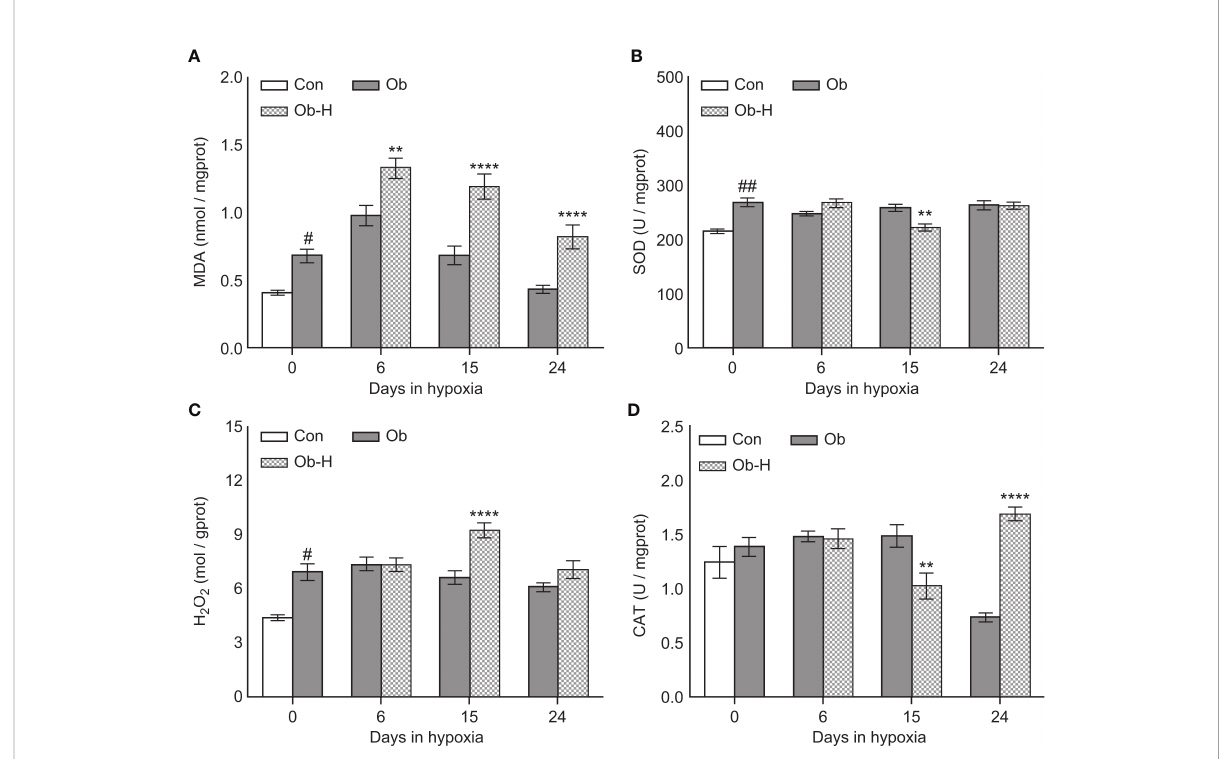
FIGURE 6 Chronic high-altitude hypoxia exposure aggravated testicular tissue oxidative stress in obese male mice. (A) MDA; (B) SOD; (C) H 2 O 2 ; (D) CAT. Data are represented as mean ± SEM. (A – D) n = 12 – 22, # P < 0.05 vs Con, ## P < 0.01 vs Con, ** P < 0.01 vs Ob, **** P < 0.0001 vs Ob. Con, Control group; Ob, Obese group; Ob-H, Obese-Hypoxia group.